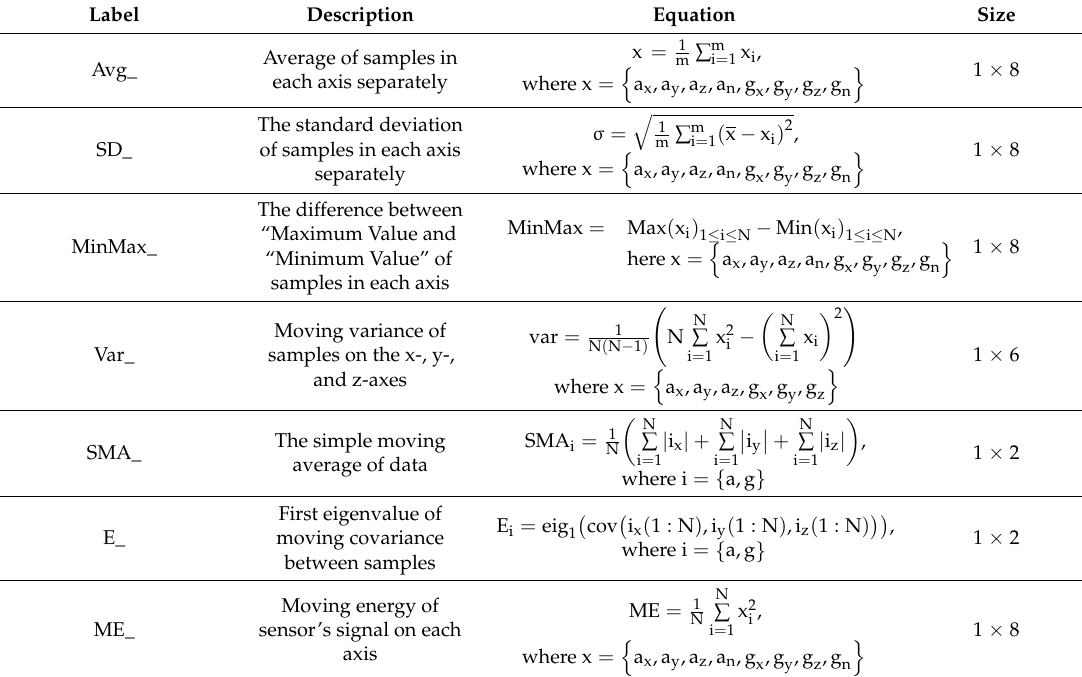
Table 2. The list of features extracted separately from accelerometers and gyroscopes